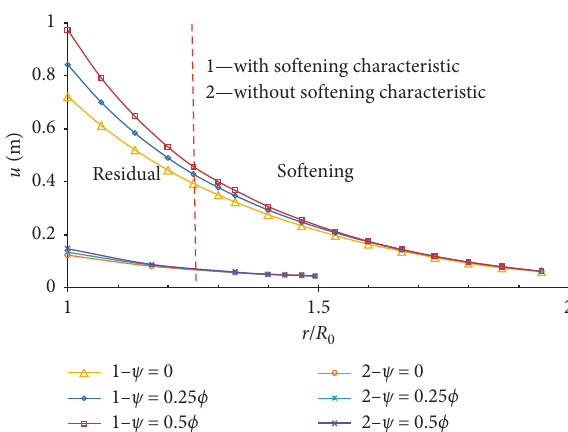
Figure 4: Relationships between dilation angle and displacements of salt cavern in plastic zone.